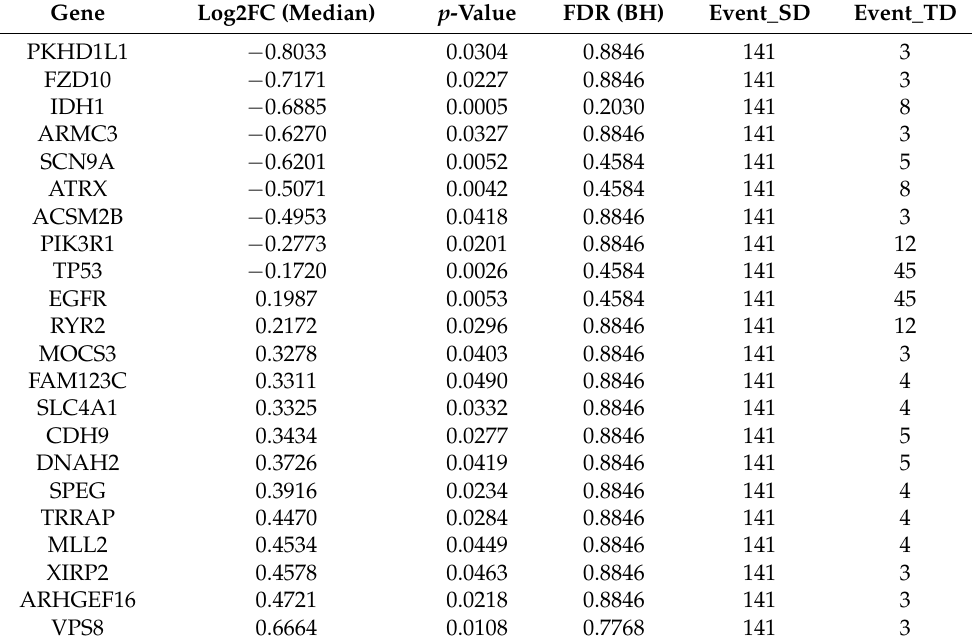
Gene, gene in given target dataset whose association with SHPK expression has been performed. Log2FC (median), change in gene expression level expressed in log2 of mutated/WT ratio. p -value, p -value obtained from the Wilcoxon statistical test. FDR (BH), false discovery rate calculated by BH (Benjamini–Hochberg method). Event_SD, Number of observations in search dataset attribute without NA’s and Zero’s. Event_TD, Number of observations in target dataset attribute without NA’s and Zero’s.